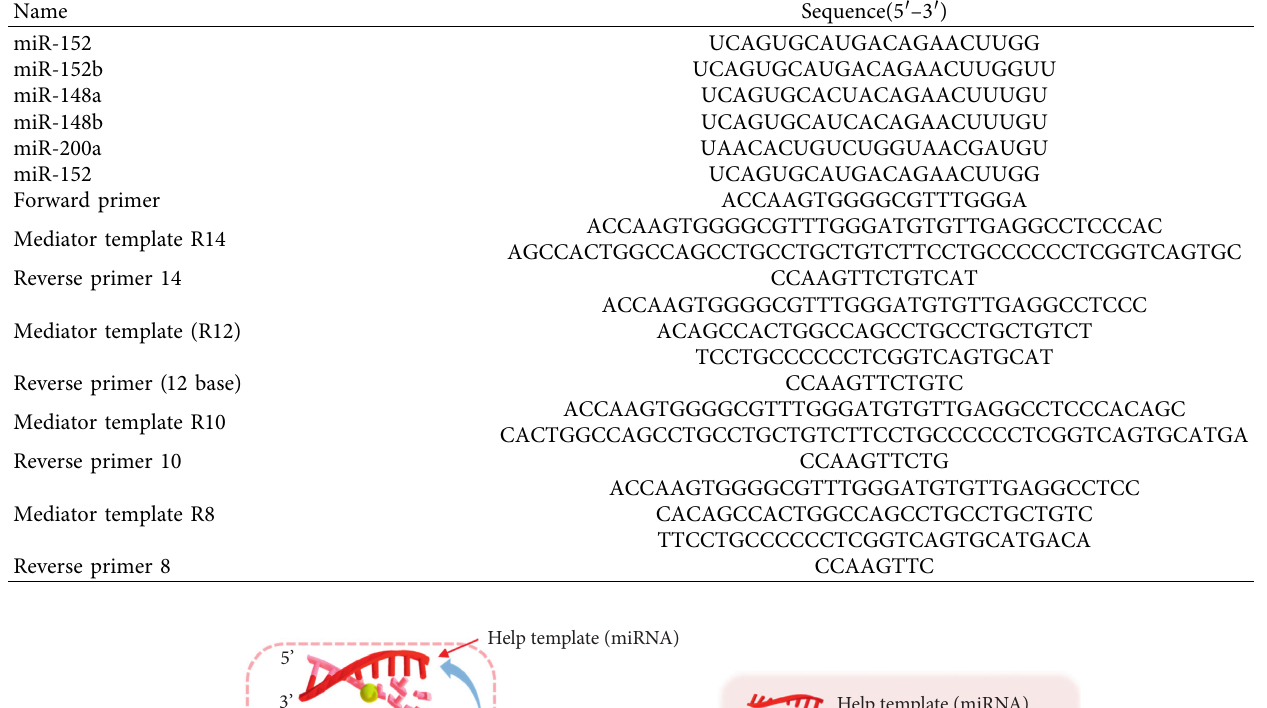
Table 1: RNA and DNA sequences used in this work.